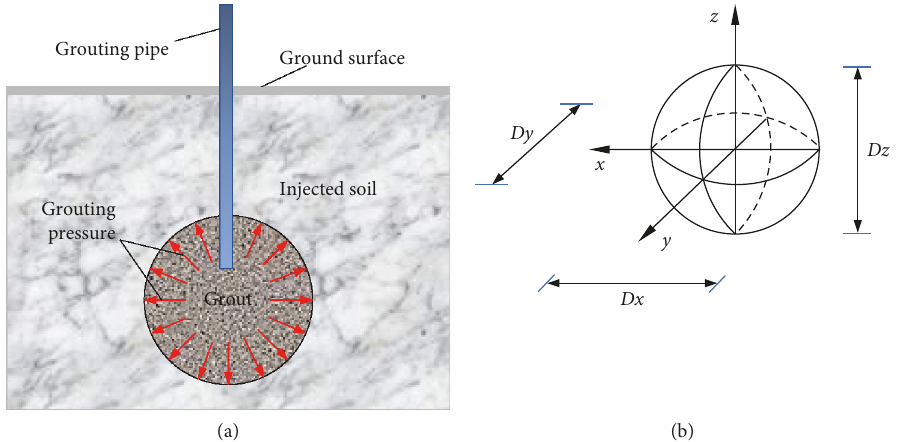
Figure 1: Diagram of the (a) grout permeation diffusion and (b) direction indication of grout concretion.